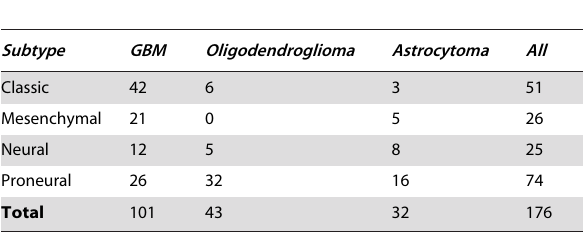
Table 2. Classification of Rembrandt samples using the TCGA molecular subtype gene signatures derived from the PAM